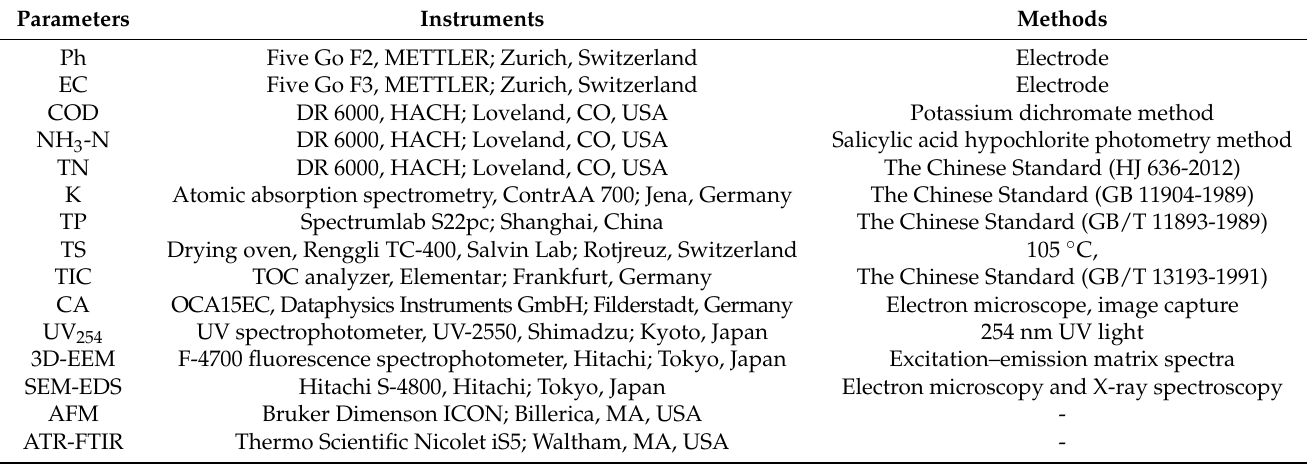
Table 4. Main tested parameters, instruments, and methods in this